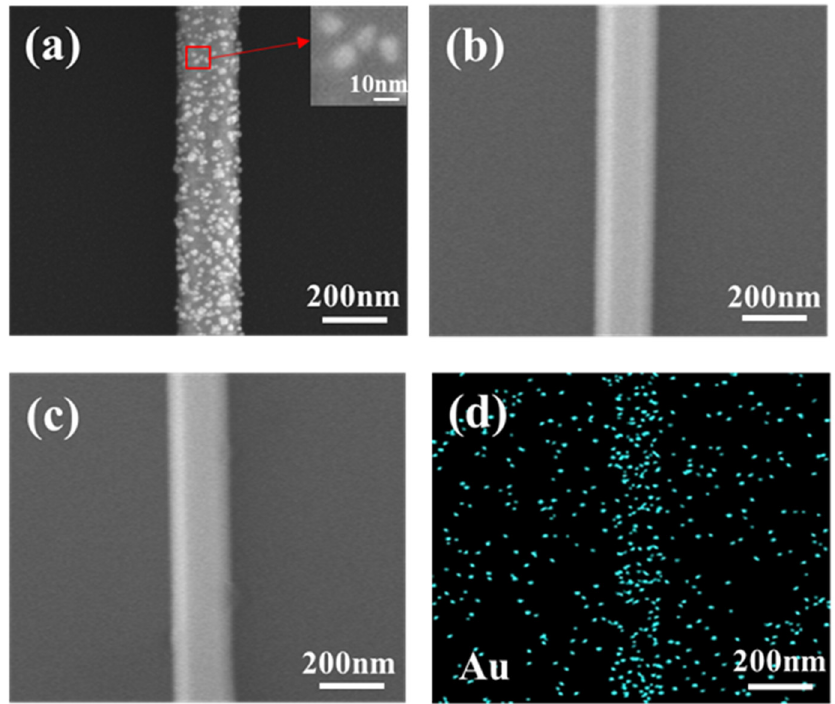
Figure 3. ( a – c ) SEM images of GaAs nanowires under modification time of 10 s, 30 s, 50 s, respectively. ( d ) Energy dispersive X-ray spectroscopy (EDX) of Au nanoparticles under modification time of 10 s. The I-V characteristic curves of the GaAs nanowire photodetectors with different modification times and their corresponding unmodified devices under a 532 nm excitation